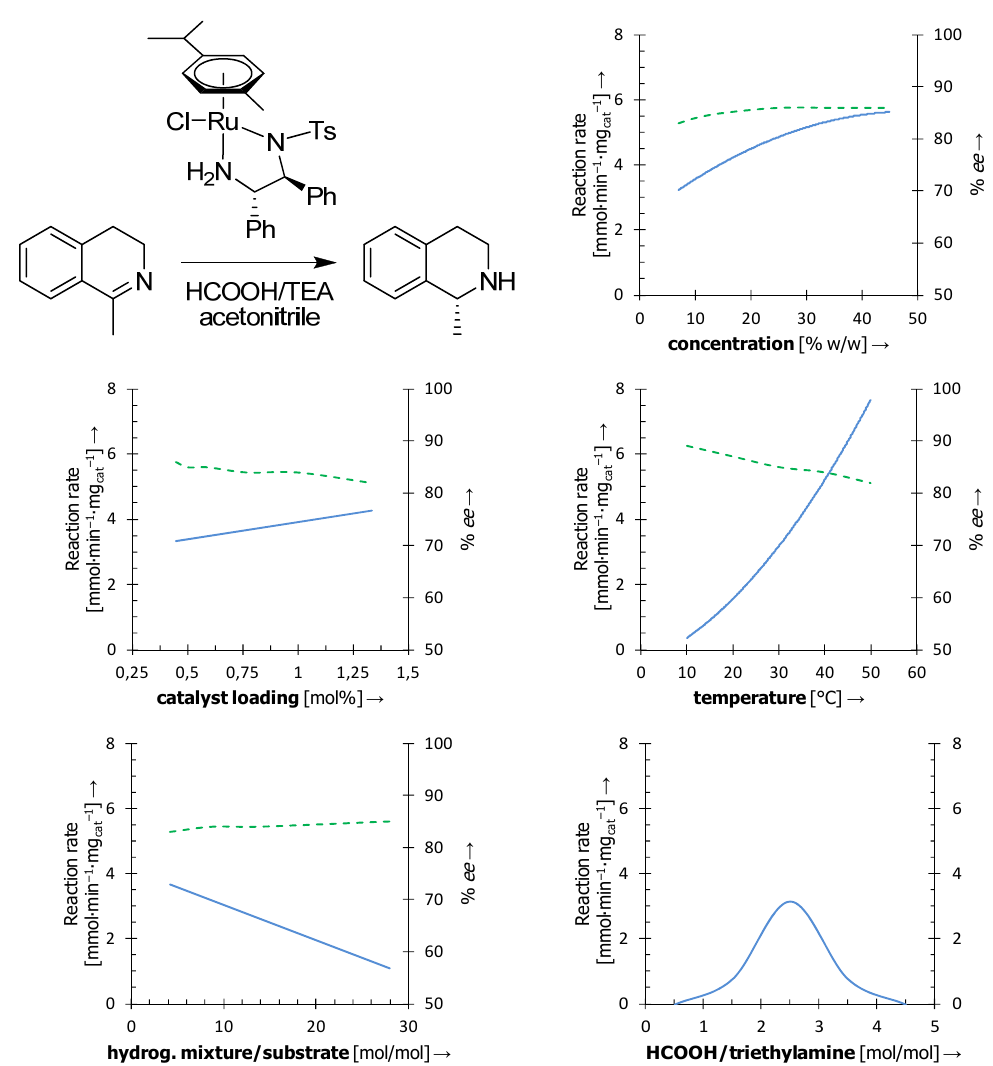
Figure 1. Schematic representation of the influence of individual parameters on the reaction rate (blue solid line) and/or enantioselectivity (green dashed line) of the ATH